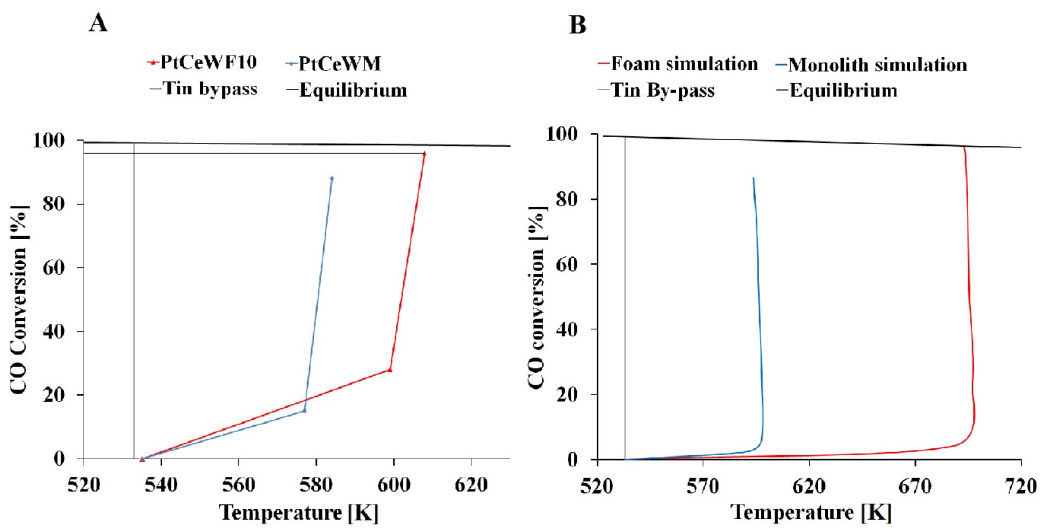
Figure 7. CO conversion versus temperature profile: experimental ( A ) and simulated ( B ).